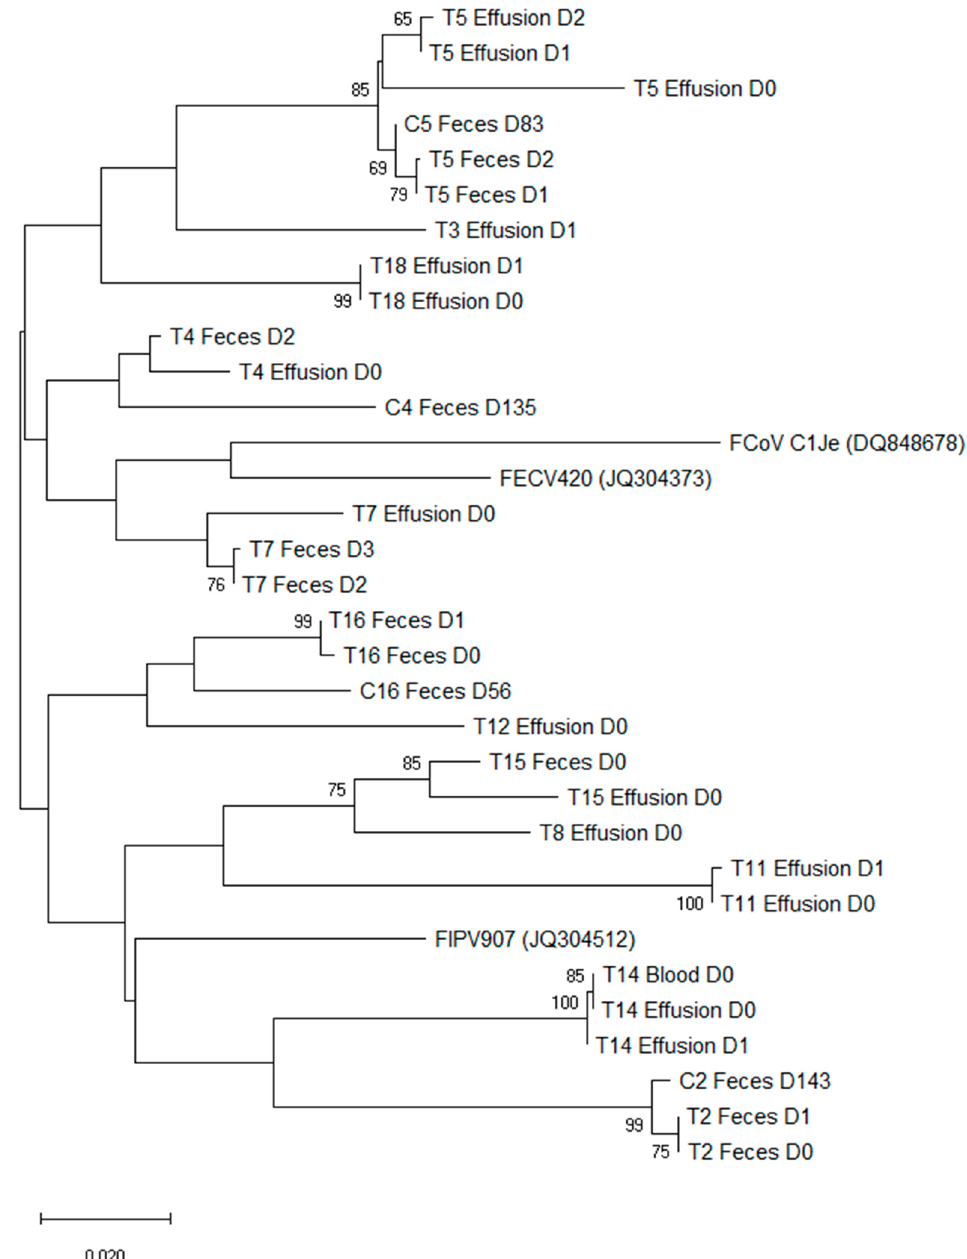
Figure 5. Bootstrap phylogenetic tree of spike (S) gene sequences. The evolutionary history was inferred using the Minimum Evolution (ME) method [55]. The optimal tree is shown. The percentages of replicate trees in which the associated taxa clustered together in the bootstrap test (1000 replicates) are shown next to the branches (values below 60 are not displayed) [56]. The tree is drawn to scale, with branch lengths in the same units as those of the evolutionary distances used to infer the phylogenetic tree. The evolutionary distances were computed using the Jukes–Cantor method and are in the units of the number of base substitutions per site. The ME tree was searched using the Close Neighbor Interchange (CNI) algorithm [57] at a search level of one. The Neighbor Joining algorithm [58] was used to generate the initial tree. This analysis involved 86 nucleotide sequences. All ambiguous positions were removed for each sequence pair (pairwise deletion option). In total, there were 155 positions in the final dataset. Evolutionary analyses were conducted in MEGA X [53]. Each sequenced FCoV strain is defined by the cat ID (T: treated FIP cat; C: companion cat), the com- partment from which it has been isolated (feces, blood, effusion), and day of treatment (D#). Three